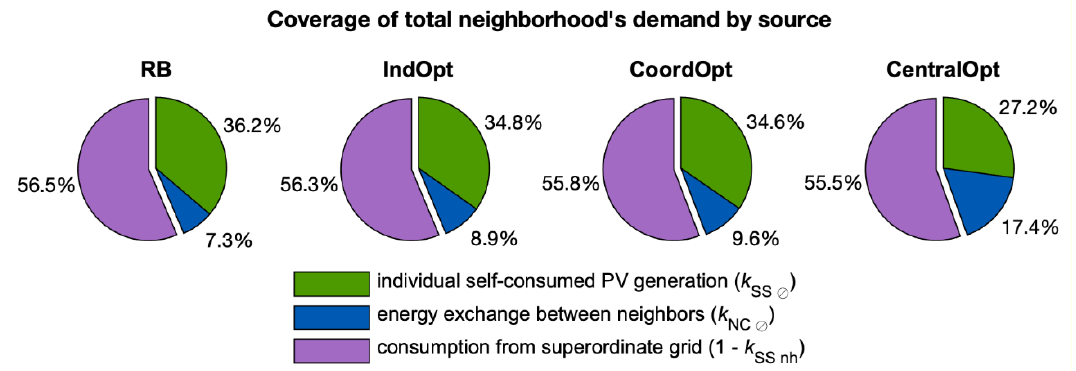
Figure 10. Coverage of the total neighborhood’s demand by source for the investigated EM concepts.